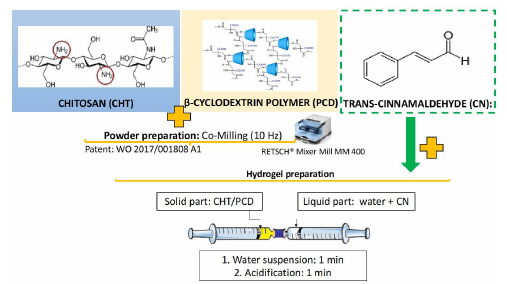
Figure 9. Graphical description of the hydrogel preparation system composed of two syringes interconnected by a female-female Luer